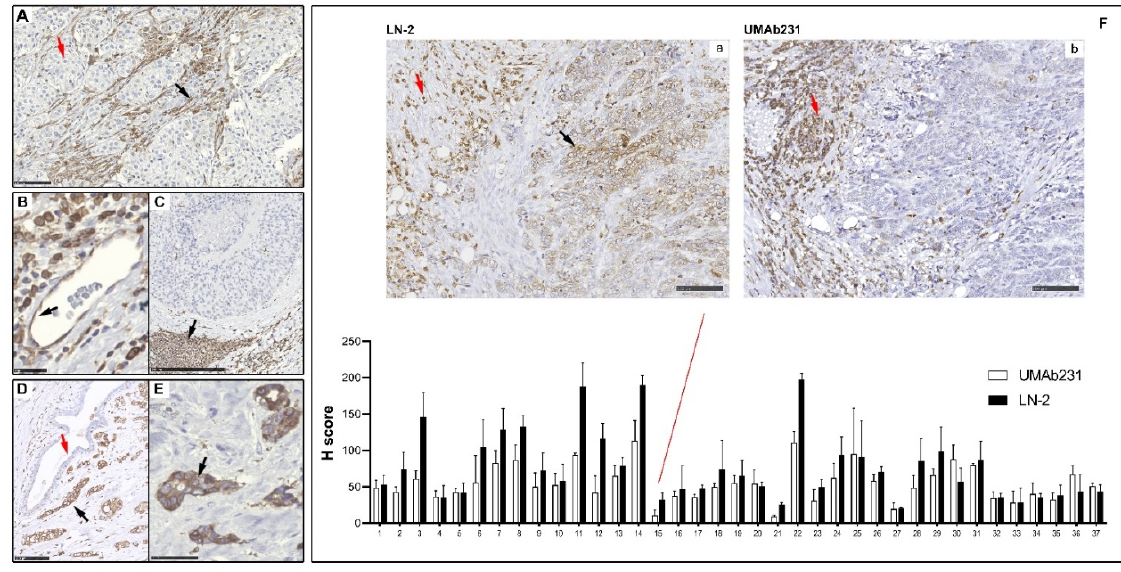
Figure 2. IHC staining patterns of UMAb231. Immunoreactivity for CD74 was seen primarily in stromal components, ( A ) in peritumoral fibroblasts, ( B ) endothelial cells, and ( C ) lymphocytes and macrophages, respectively (black arrows). Staining of serial sections with vimentin, CD4, CD8, CD68 or CD31 was used to confirm cell identity. In some samples, CD74 was also expressed in ( D ) tumor cells (black arrow indicates tumor cells), with essentially cytoplasmic and ( E ) membrane staining (black arrow indicates membrane staining). ( F ) Comparative semi-quantitative analysis of the UMAb231 and LN-2 antibodies, showed similar, but not always identical, patterns between the two antibodies. A case is highlighted with no CD74 immunoreactivity in tumor cells with UMAb231 (sub-panel b), but weak to moderate reactivity with LN-2 (sub-panel a, black arrow). In both cases lymphocytes and macrophages stained strongly with either antibody (sub-panels a and b, red arrows, respectively). Scale bars are 100 µ m in ( A , D , F ), 25 µ m in B, 250 µ m in ( C ), and 50 µ m in ( E ),